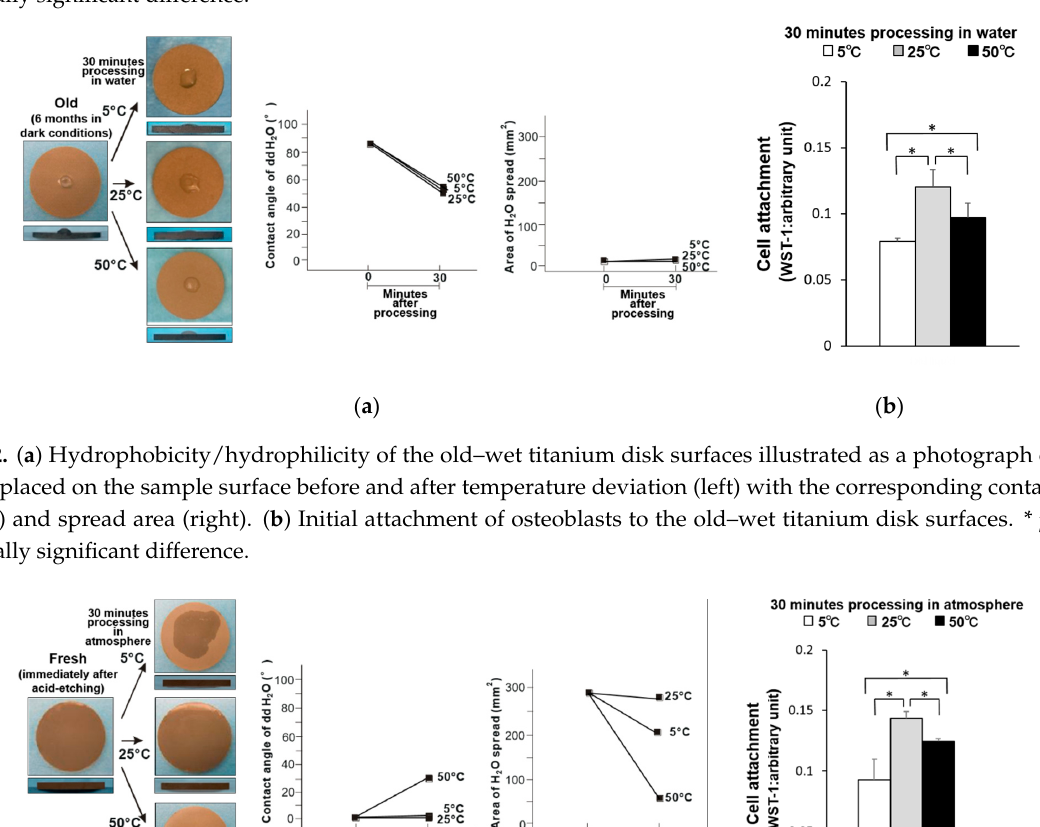
( b ) Figure 4. ( a ) Hydrophobicity/hydrophilicity of the fresh–wet titanium disk surfaces illustrated as a photograph of 10 µL ddH 2 O placed on the sample surface before and after temperature deviation (left) with the corresponding contact angle (middle) and spread area (right). ( b ) Initial attachment of osteoblasts to the fresh–wet titanium disk surfaces. * p < 0.05, statistically significant difference. The relationship between storage temperature and cell attachment was investigated using regression analysis. Cell attachment increased from 5 °C to room temperature (25 °C) and subsequently decreased from room temperature to 50 °C, thus curved regression was more suitable than linear regression. Specifically, a quadratic curve fit the relation- ship between storage temperature and cell attachment with a very high coefficient of de- termination ( R 2 = 0.81), and initial cell attachment peaked at 31 °C (Figure 5). Subse- quently, the relationship between initial cell attachment and hydrophilicity was evaluated at each storage temperature (5, 25, and 50 °C) (Figure 6). Overall, there was no significant correlation between hydrophilicity and initial cell attachment ( R = − 0.35) (Figure 6a). How- ever, there was some negative correlation between hydrophilicity and initial cell attach- ment when each storage temperature was evaluated separately ( R = − 0.77, − 0.88, and − 0.70 for 5, 25, and 50 °C, respectively) (Figure 6b–d).